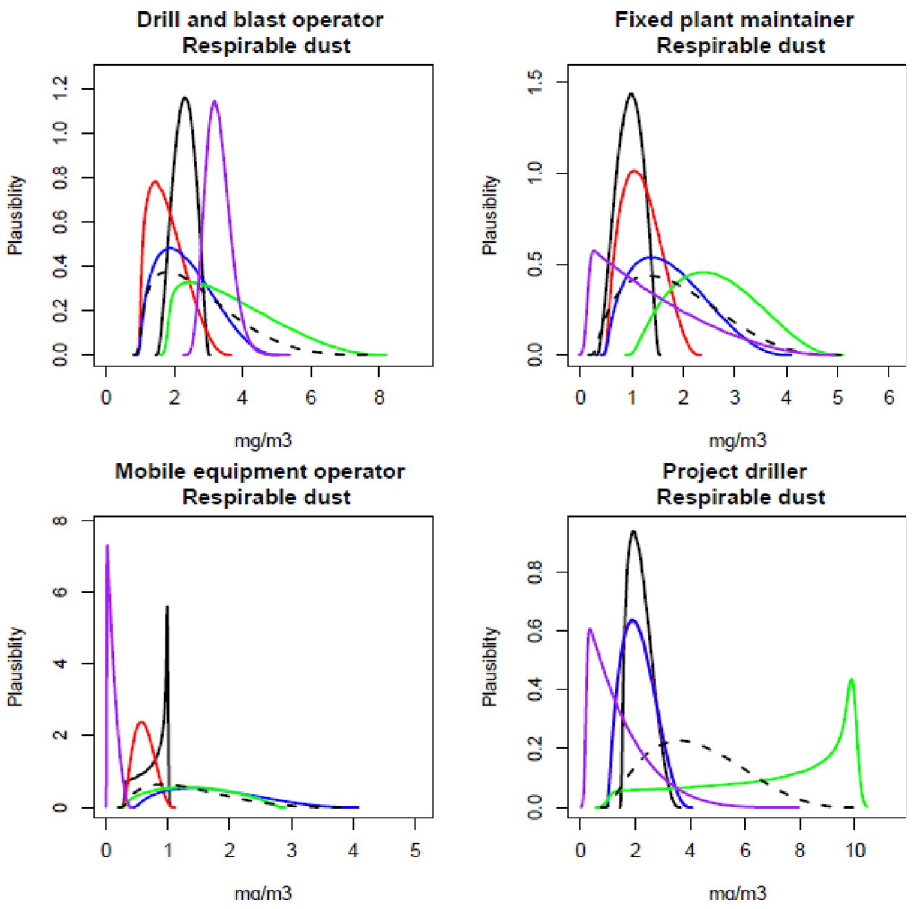
Fig 3. Expert estimates and measured data of respirable dust concentrations. Each curve depicts the experts support (probability density) or measured data encoded into a scaled Beta distribution. Experts are denoted in the colours blue, red, black and green; combined experts are the dashed line. Measured data is presented as purple.